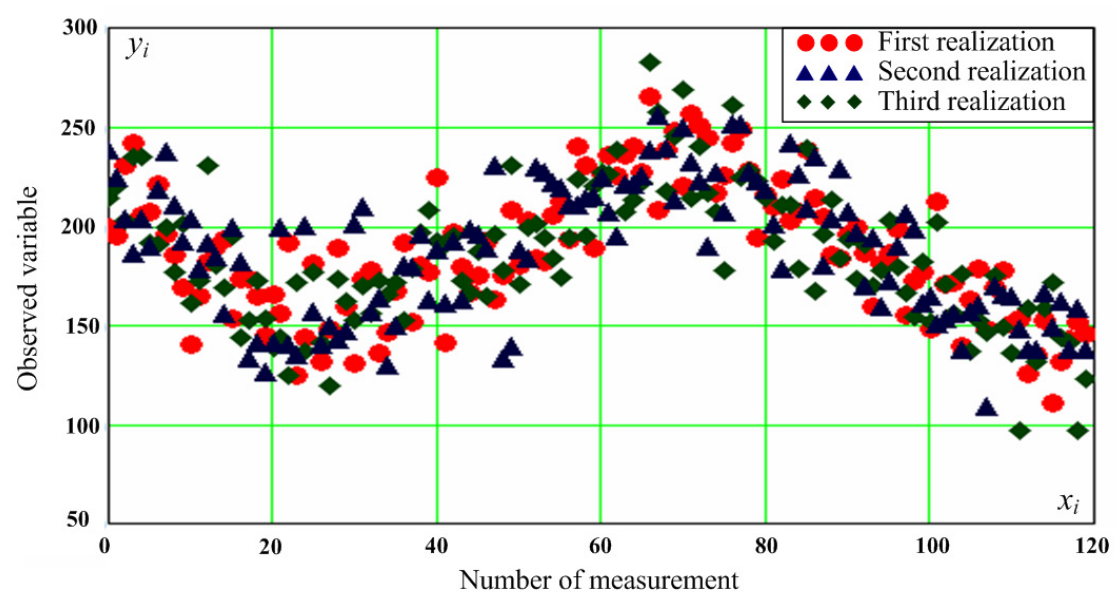
Figure 2. Examples of generated additive mixture of SLR model and Gaussian noise.